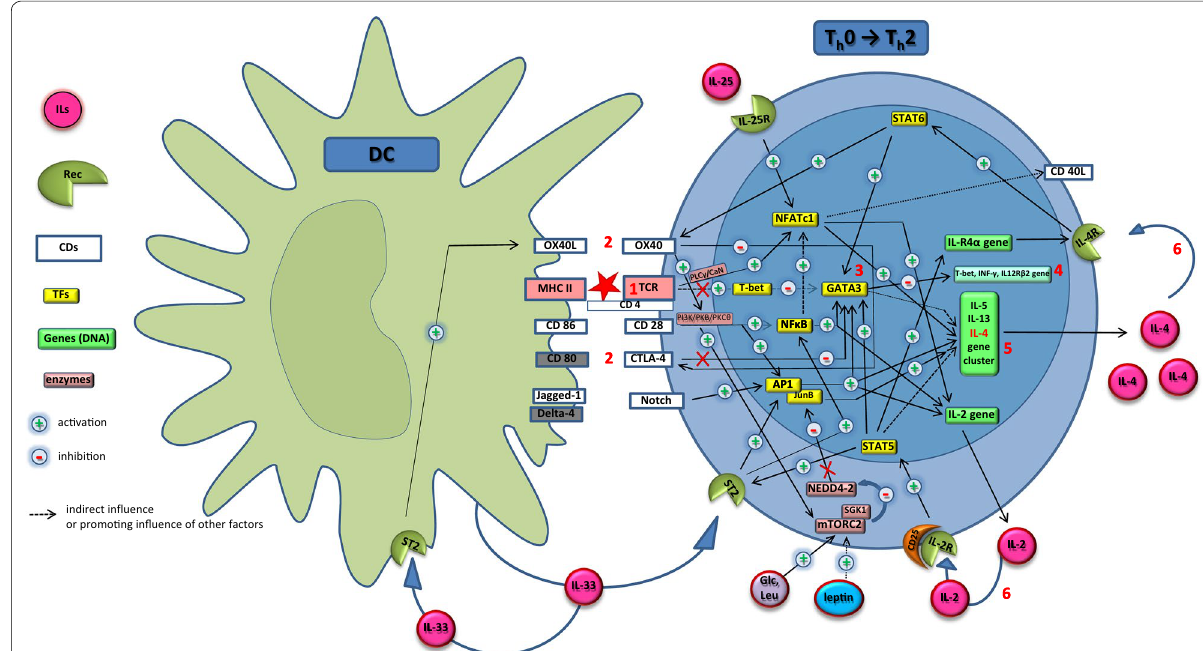
Fig. 3 Differentiation of naïve Th cells into Th2 cells. The T cell receptor (TCR) is triggered by the specific recognition of allergenic peptides presented by MHC molecules (MHC II) (event 1). Even in the absence of TCR triggering, the co‑stimulatory and co‑inhibitory receptors on the T cells direct the T cell polarization and determine the T cell fate (events 2). The upregulation of transcription factor GATA‑3 (event 3) is essential in the polarization towards Th2 since it suppresses Th1 and Th17 polarizing events (event 4) while promoting the IL‑4, IL‑5 and IL‑13 gene translation (event 5), the so called keystones of the Th2 response. Cytokines produced by these polarized Th2 cells, including IL‑2 and IL‑4 can self‑amplify the differentiation process (events 6). ILs interleukins, Rec receptors, CDs cluster of differentiation, TF transcription